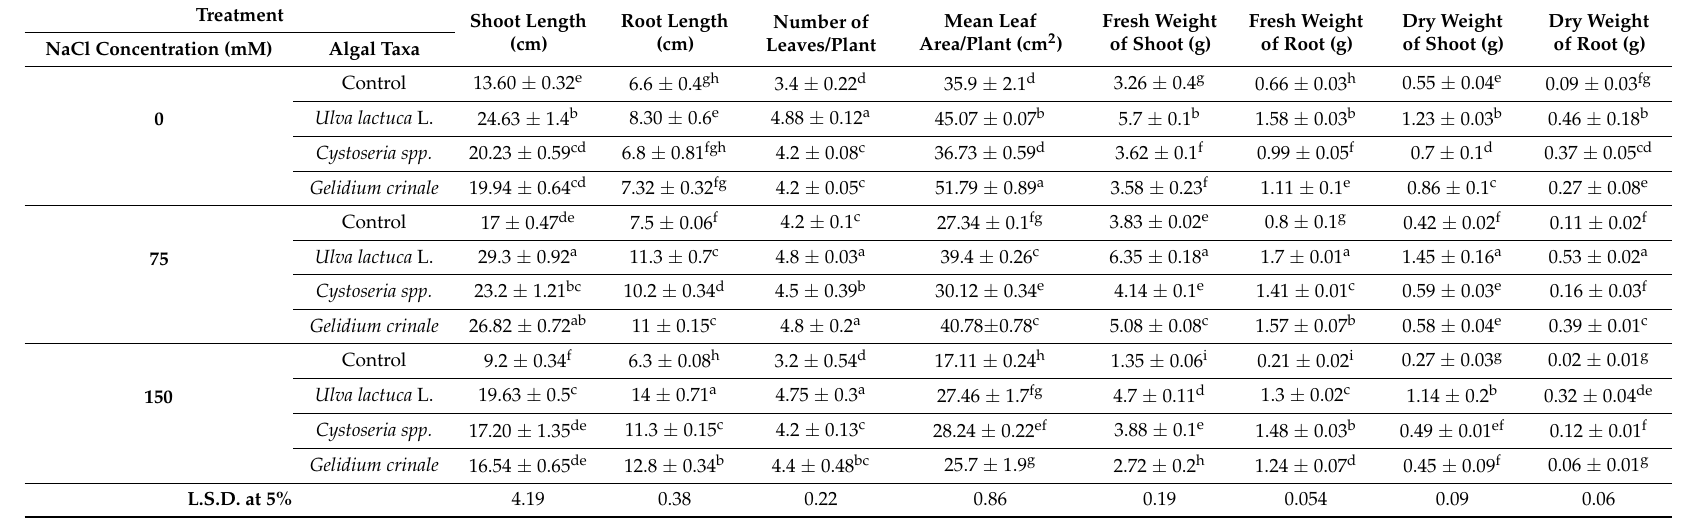
Table 2. The impact of Ulva lactuca L., Cystoseria sp., and Gelidium crinale soil treatment on growth parameters of canola plants (at the vegetative stage) grown under different levels of salinity. Data are presented as the mean ± SD ( n =